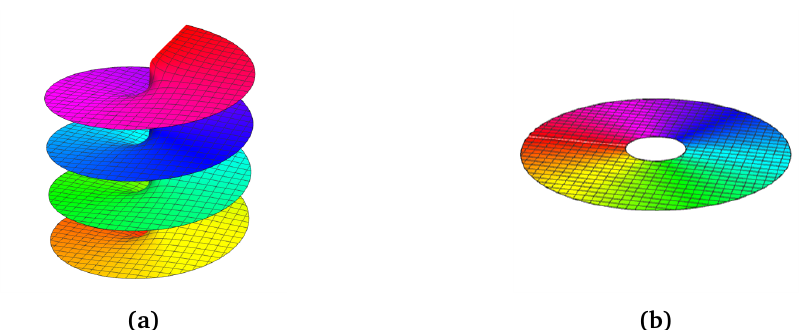
Figure 1: (a) A screw dislocation through a stack of 2D layers connects the layers together. (b) The structure in (a) can be expanded into an annulus on a single plane, with the screw dislocation becoming the inner boundaries.